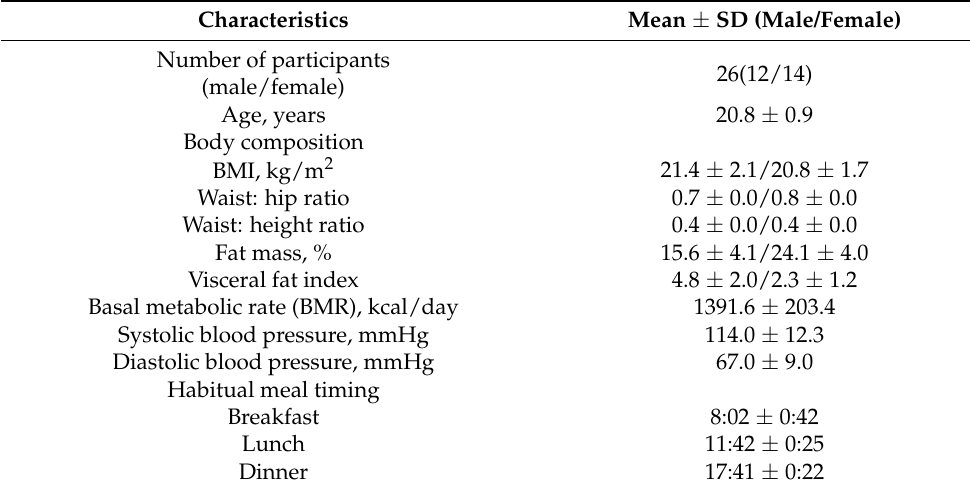
Table 2. Baseline characteristics of study